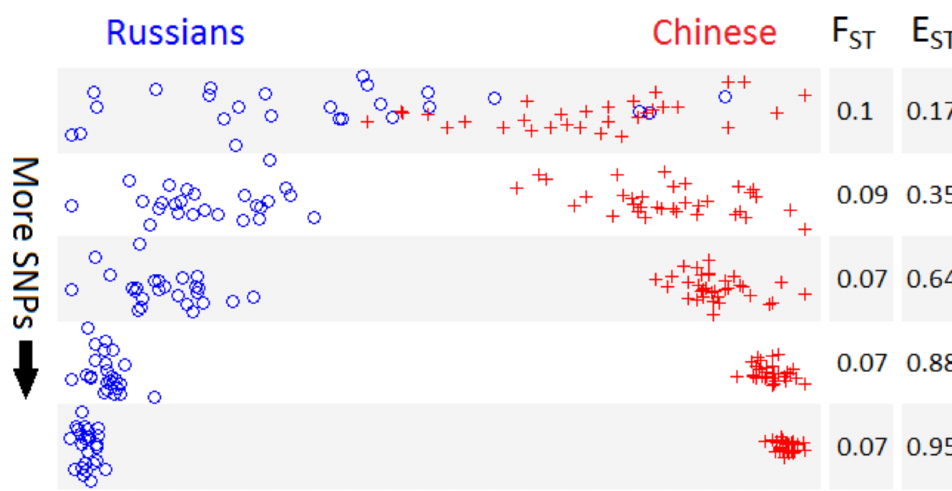
Fig 2. F ST and E ST vs. Clustering with increasing SNP count. Multidimensional scaling (MDS) plots with Russian (n = 25) and Chinese (n = 34) samples with increasing SNP count from top to bottom (10, 100, 1000, 10,000, and 660,755 SNPs). Two clusters gradually emerge as SNP count increases, along with an increase in E ST , while F ST remains relatively